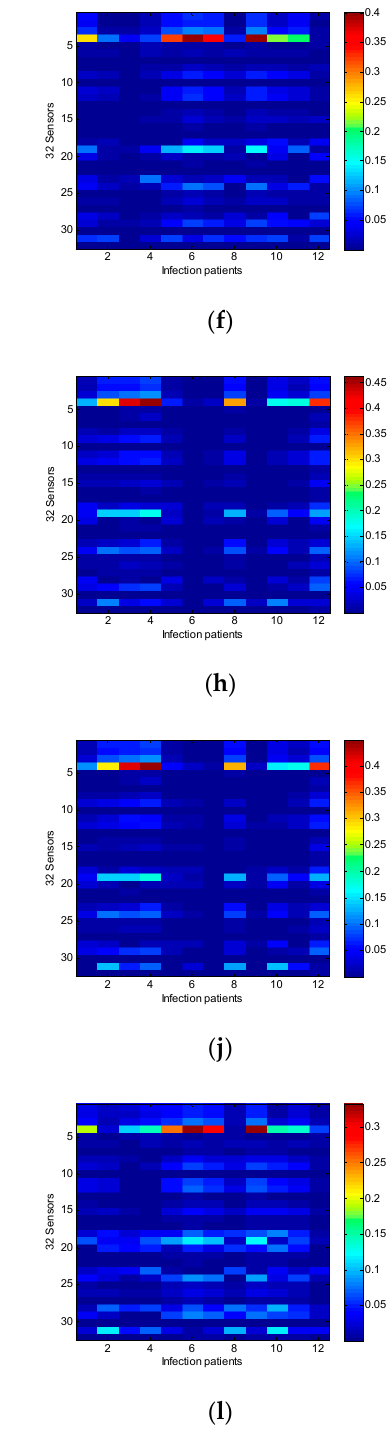
Figure 3. The mean absolute error of the value of sensor resistance between the data of total 12 patients infected with pneumonia and the data of each non-infected patient (i.e., from ( a ) to ( l ) of all 12 patients) in all 32 sensors.